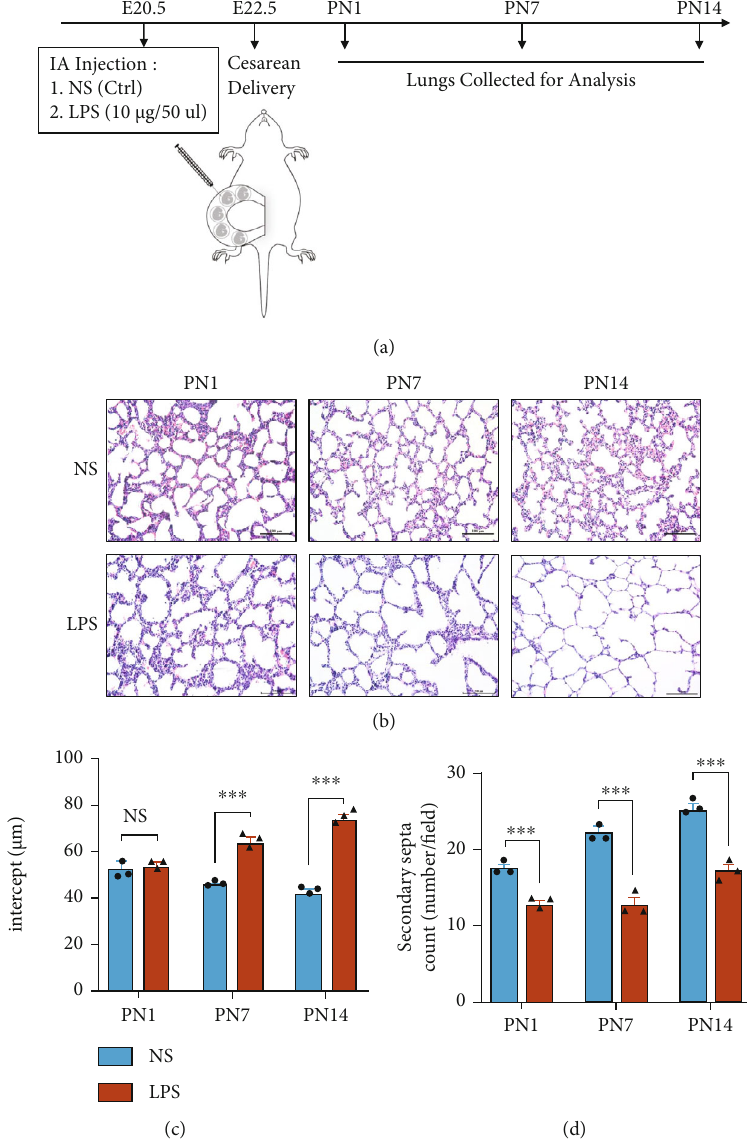
Figure 1: Establishment and characterization of bronchopulmonary dysplasia (BPD) model induced by intra-amniotic injection of LPS (IA-LPS). (a) The schedule involved experimental BPD rat model caused by intra-amniotic (IA) injection of normal saline (NS) or LPS and time points to collect lungs. (b) Representative lung sections stained with H&E on postnatal day 1 (PN1), PN7, and PN14, scale bar = 100 μ m. Quanti fi cation of the (c) mean linear intercept (MLI) and (d) secondary septa ( N = 3 , t -test, NS: not signi fi cant, ∗∗∗ P < 0 : 001